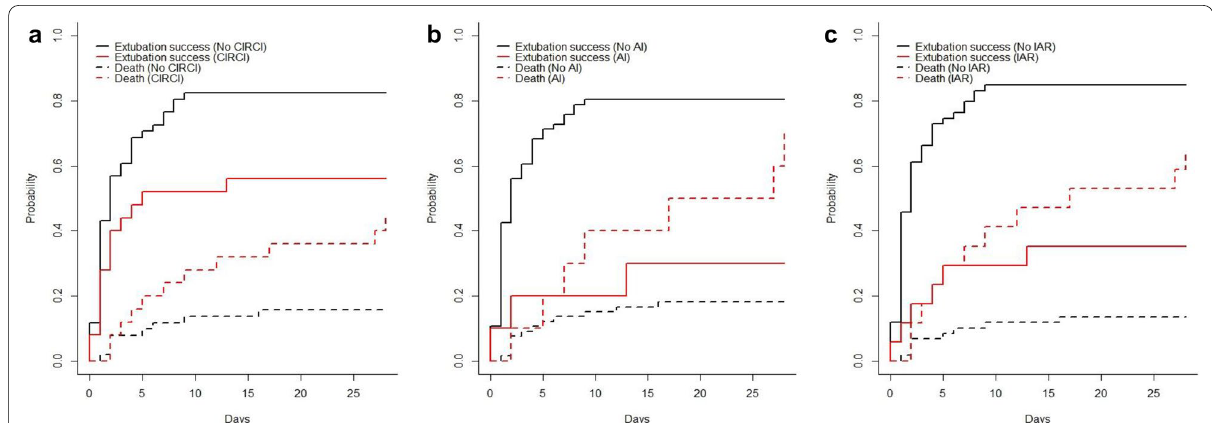
Fig. 2 Cumulative probability of extubation success and death in patients with altered adrenal function (in red) and preserved adrenal function (in black). Time from weaning to extubation success (continuous line), and to death (dashed line) were handled as competing risks. Altered adrenal function was assessed as CIRCI ( a ), adrenal insufficiency (as per Hang and Lin definition) ( b ) or inadequate adrenal reserve ( c